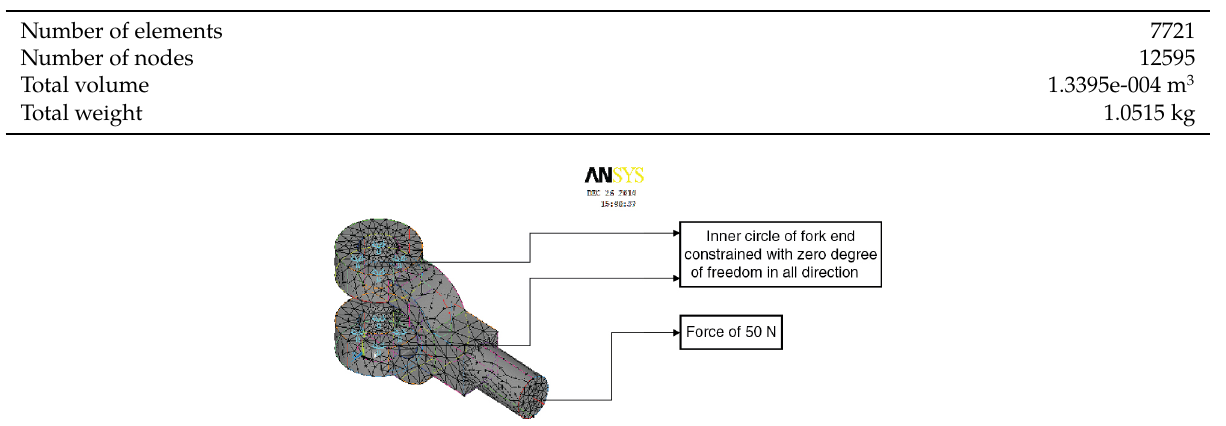
Figure 2: (A) CAD model (B) mesh model in ANSYS.